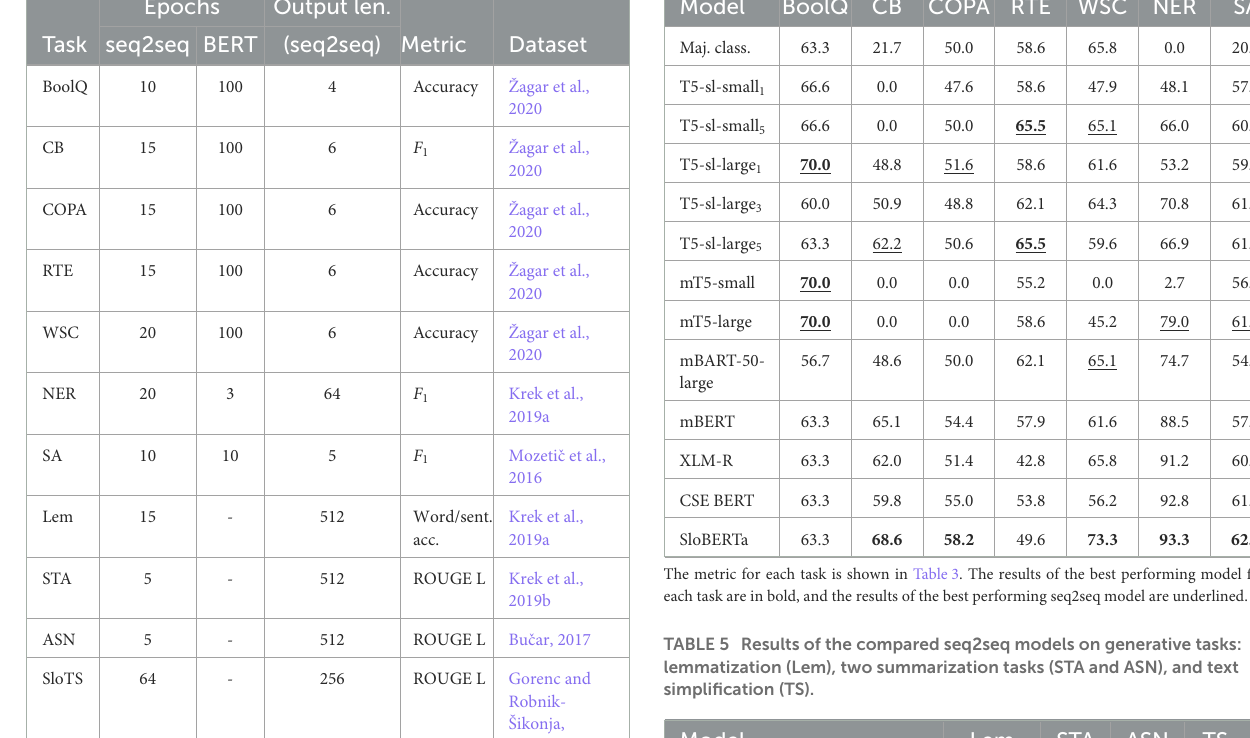
TABLE 3 Evaluation parameters and performance metrics for seq2seq and BERT models for each of the datasets. Epochs Output len.